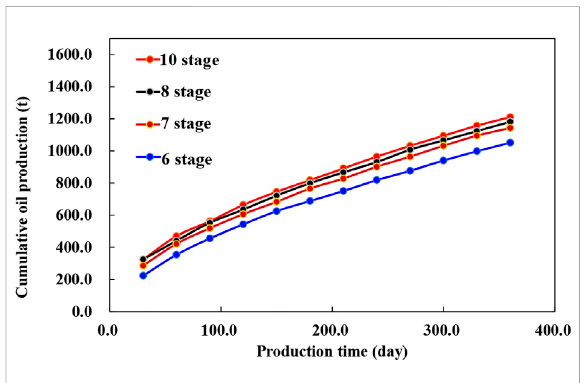
FIGURE 14 Relationship between the number of fracturing fractures and cumulative oil